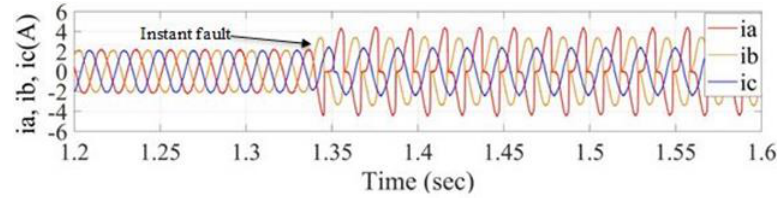
Figure 25. Stator current signals for no-load with 25% fault in phase (a).